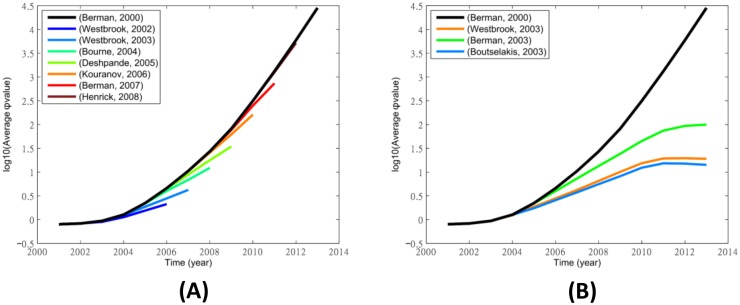
Compare the growth of the PDB debut paper’s cascade with (A) all the residue cascades created by its follow-up articles in 5 years (τ = 5) and (B) the residue cascades created by three 2003 follow-up articles. The y-axis of both panels shows the logarithm of the annual average cascade function values Φ, defined in Eq (3).